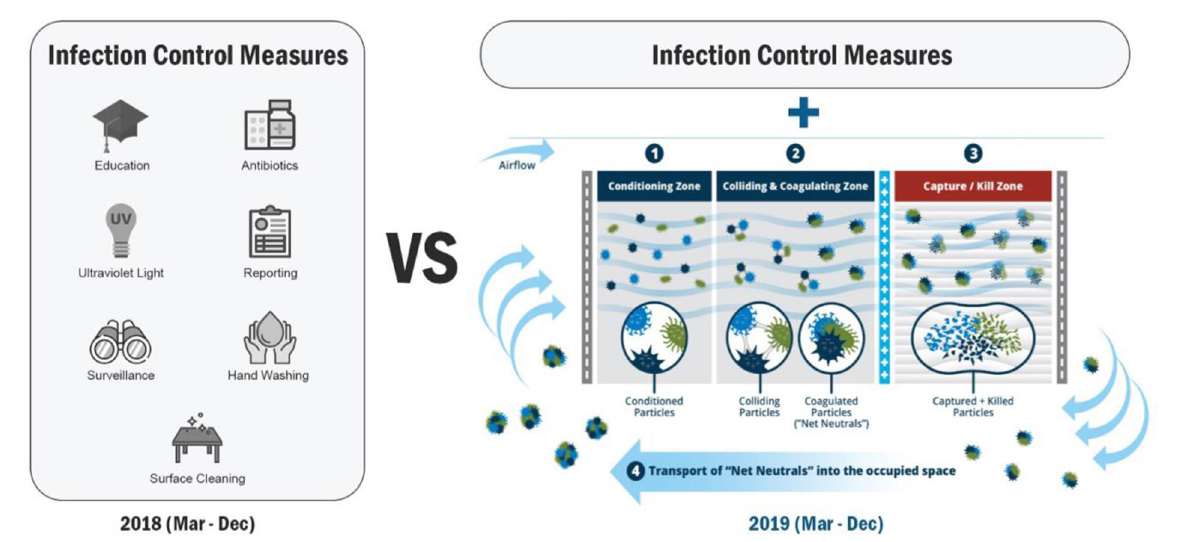
FIGURE1 Study Methods: Comprehensive infection control measures included education and training, hand washing, isolation, surveillance and reporting, antibiotics, and selective ultraviolet light use in the index year (2018). All measures continued during the intervention year (2019) with the addition of ACTIVE Particle ControlTM (APC) technology. APC Mechanism of Action: ACTIVE Particle Control TM (APC) technology works by local electromagnetic field manipulation [controlled ionization, enhanced polarization, and controlled particle transport (direction and velocity)]. These forces condition microscopic (10–2,500nm) particles and pathogens (1), so they continuously initiate millions of particle-particle (ionization) and particle-molecular (polarization) collisions (2). These collisions lead to immediate and permanent ionically driven aggregations of fine and ultrafine particles and pathogens into larger particles. With the larger aggregates attaining a critical mass, their transport becomes controlled by airflow and they can be carried by air currents to the particle collector where any biologic material is killed or inactivated (3). Lastly, net-neutral particles recirculate within in the ventilated space repeating the